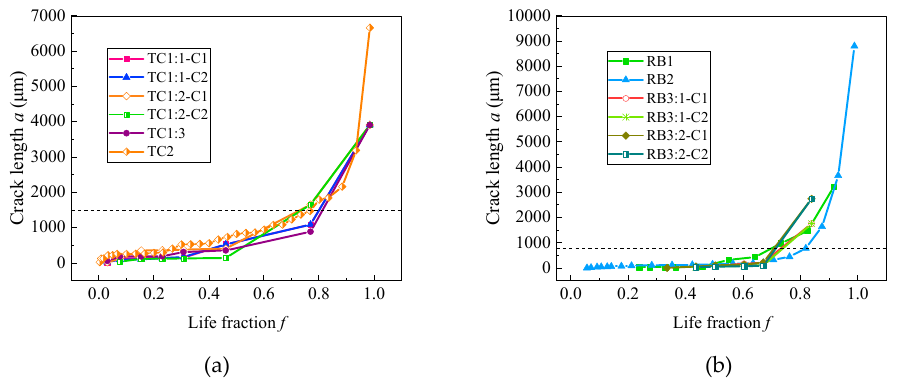
Figure 7. Curve of crack length a as a function of life fraction f : ( a ) TC specimens; ( b ) RB specimens.